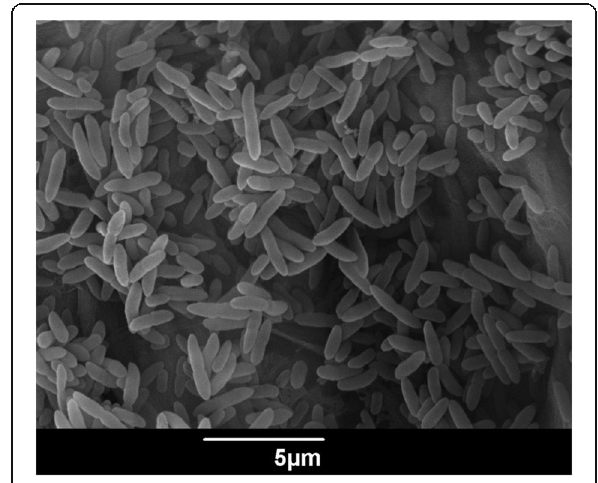
Fig. 1 Scanning electron micrograph of P. extremaustralis USBA-GBX- 515 in exponential phase. The image was obtained under a JSM6490 Scanning Electron Microscope at an operating voltage of 20.0 kV, using a modified protocol of Read & Jeffree [70]. Scale bar represents 5 μ